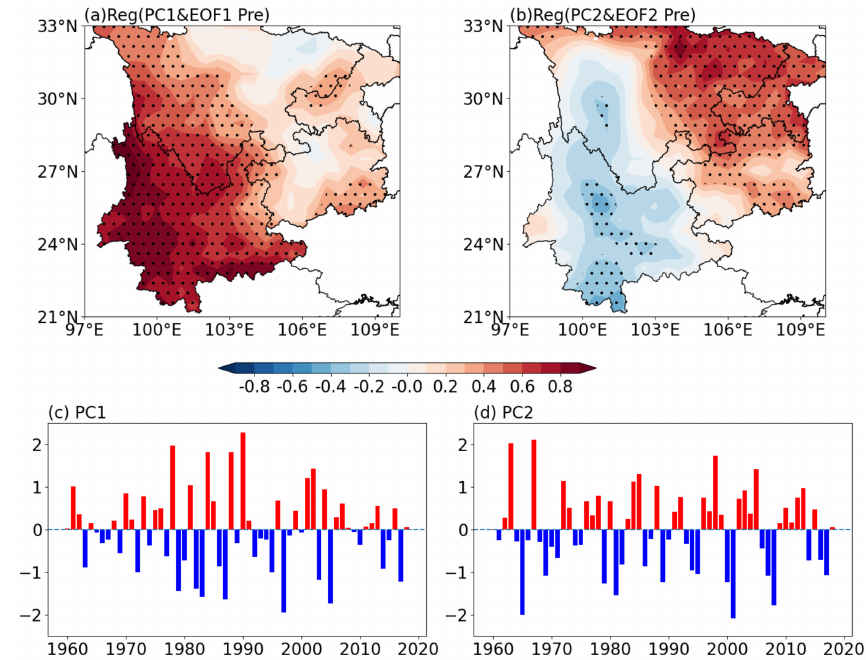
Figure 2. ( a ) Regressed anomalies of interannual components of rainfall anomaly (shaded, unit: mm) onto the interannual component of the PC1 corresponding to EOF1 of normalized rainfall anomaly in late spring in Southwest China during 1960–2018. ( b ) As in ( a ), but for PC2. ( c , d ) PC1 and PC2 time series correspond to EOF1 and EOF2, respectively. Stippling in ( a , b ) denotes rainfall anomalies that have exceeded the 95% confidence